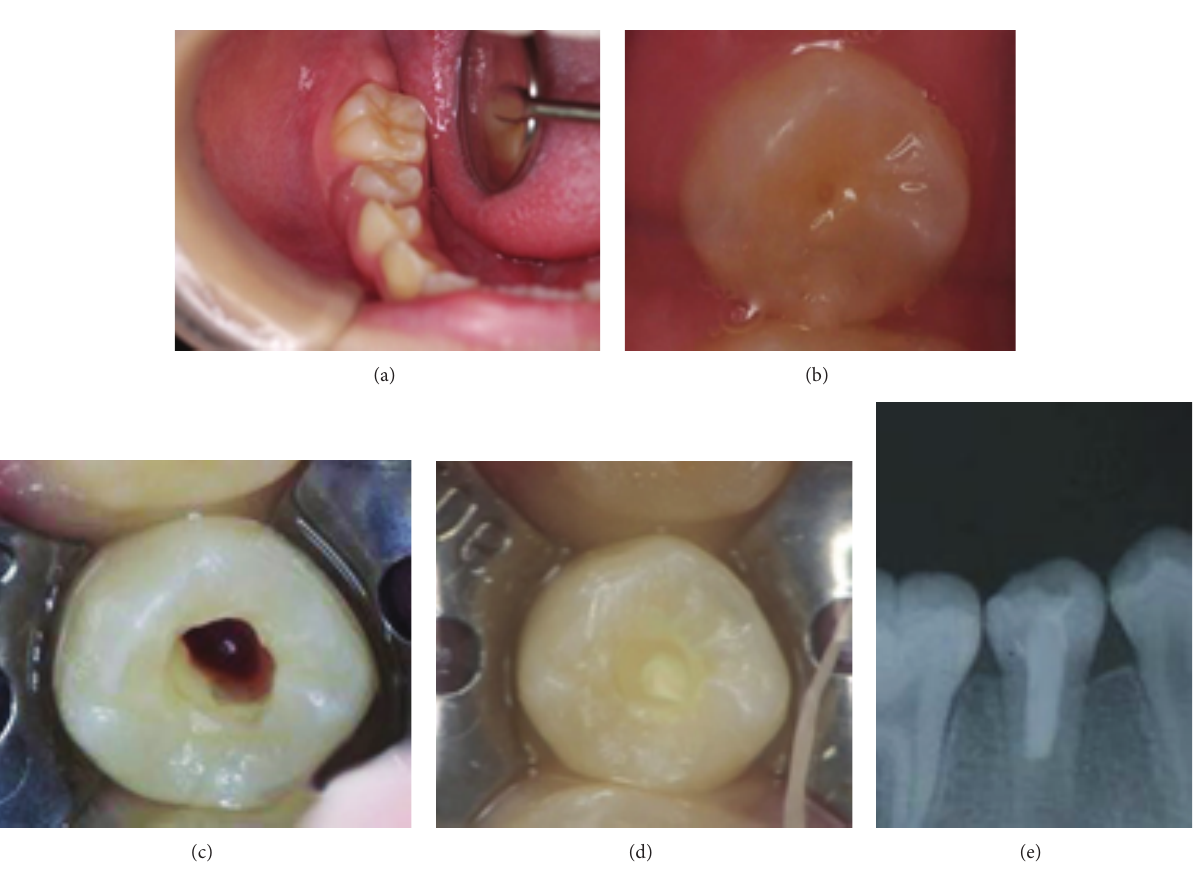
Figure 2: (a) Intraoral photograph showing no abnormalities of gingiva. (b) The central cusp of the mandibular right second premolar had been fractured. (c) After controlling hemorrhage, viable tissue was observed in the canal because insertion of a K-file evoked a sensation. (d) Placement of MTA in the canal. (e) Postoperative X-ray photograph showing MTA placement in canal.